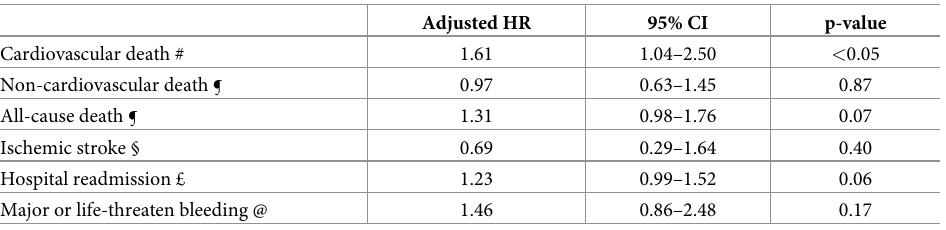
Table 3. Two-year outcomes of patients with PVD undergoing TAVI.